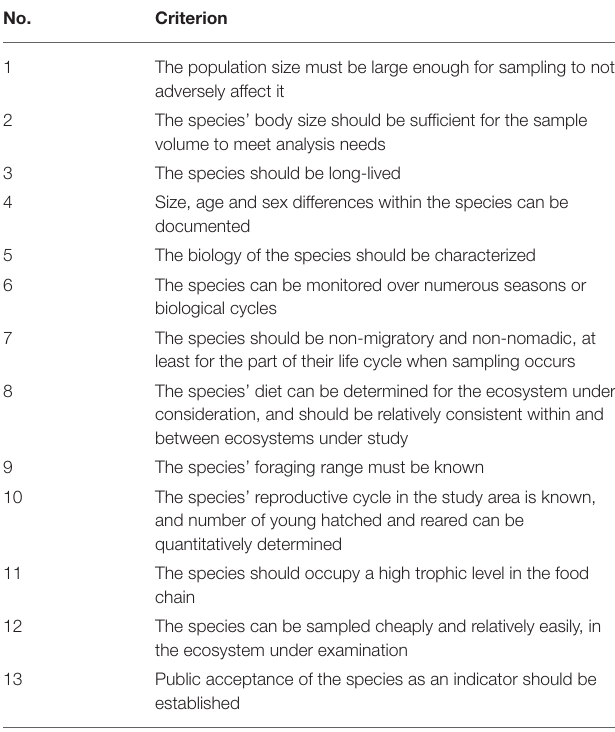
TABLE 3 | Criteria for identifying an avian biomonitor species (modified from Hollamby et al., 2006). No.